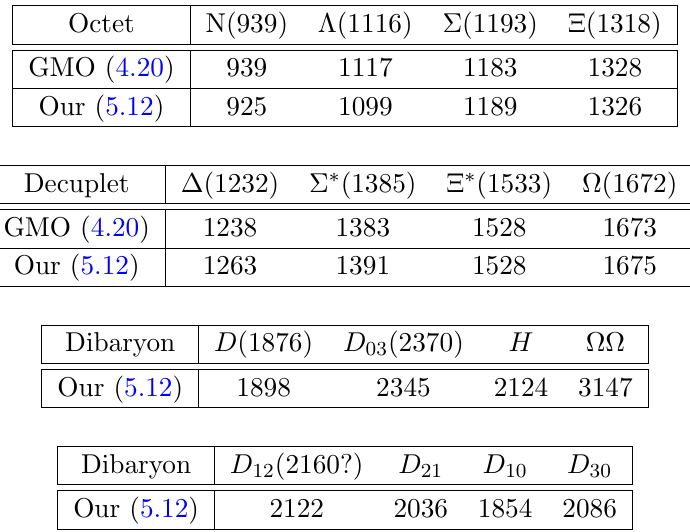
Table 6 . A numerical (cid:12)t of the hyperon and dibaryon spectrum by our formula (5.12) with (5.18) and